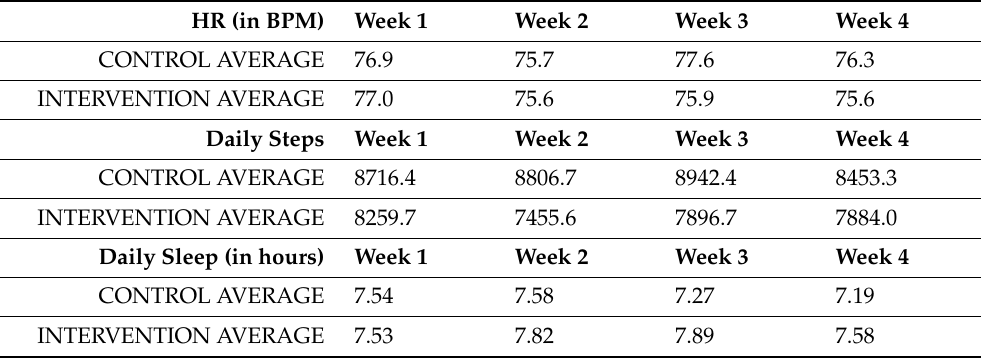
Table 1. Electronic sensor measures over